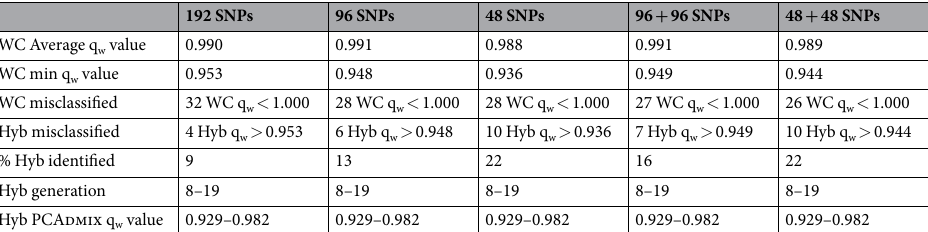
Table 2. Performance of the five reduced SNP panel sets in assignment procedures performed in Admixture on wildcat (n = 57), domestic (n = 44) and admixed individuals (n = 45), previously identified using the 35k LD-pruned SNP panel set in clustering analyses (see Results). Average and minimum membership proportions to the wild cluster of the reference wildcats (WC), number of misclassified WC showing assignment values q w < 1.000 compared to the 35k-LD pruned SNP panel set results (q w = 1.000), number of misclassified admixed cats (Hyb) showing assignment values q w ≥ minimum WC q w , percentage of hybrids correctly detected (assignment values q w < minimum WC q w ), generation time and individual membership proportions of admixed individuals retained by PCAdmix analyses on the 35k LD-pruned SNP panel set, are shown for each AIM SNP panel